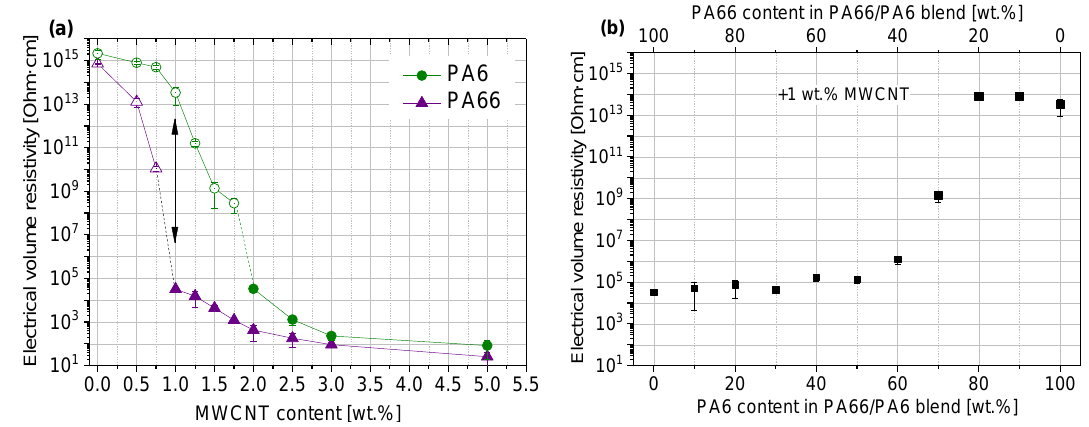
Figure 4. Electrical volume resistivity of ( a ) PA6/MWCNT and PA66/MWCNT composites and ( b ) PA6/PA66 blends filled with 1 wt % MWCNT.